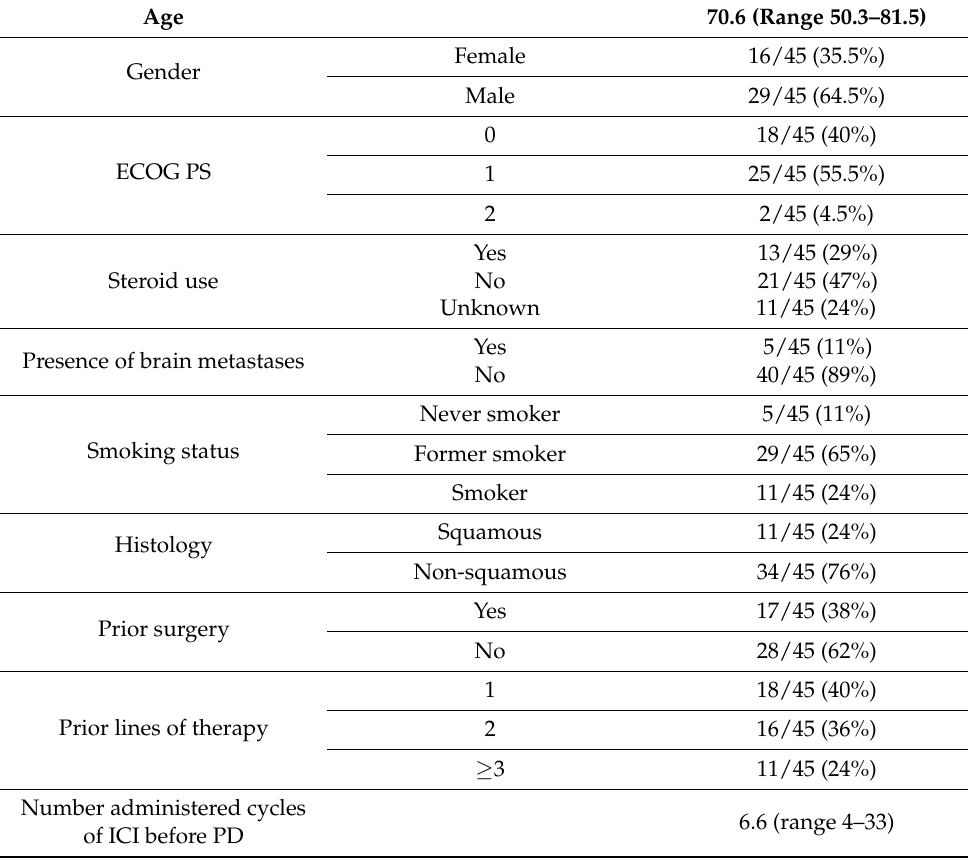
Table 1. Clinical characteristics of enrolled patients at the time of radiological